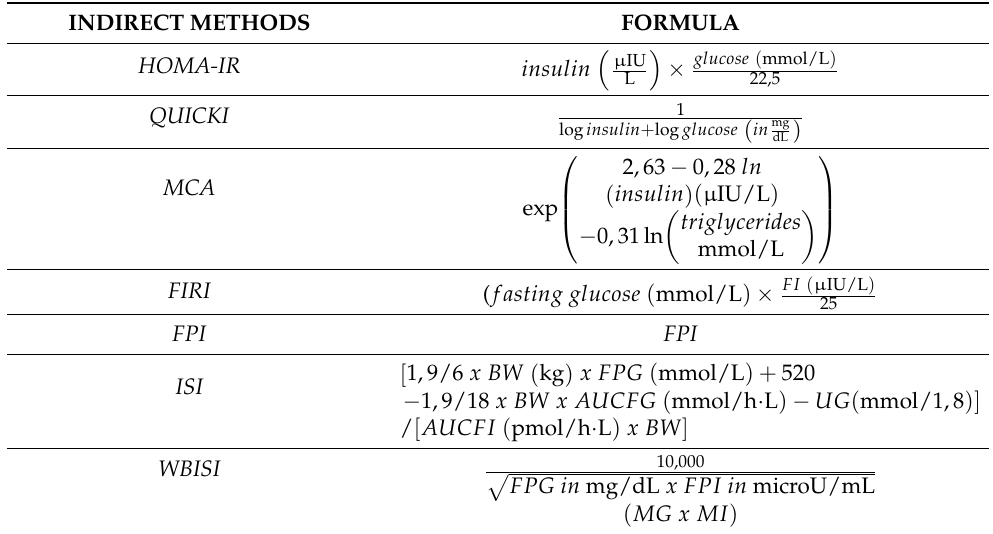
Table 1. Indirect methods of evaluating peripheral insulin sensitivity and their corresponding